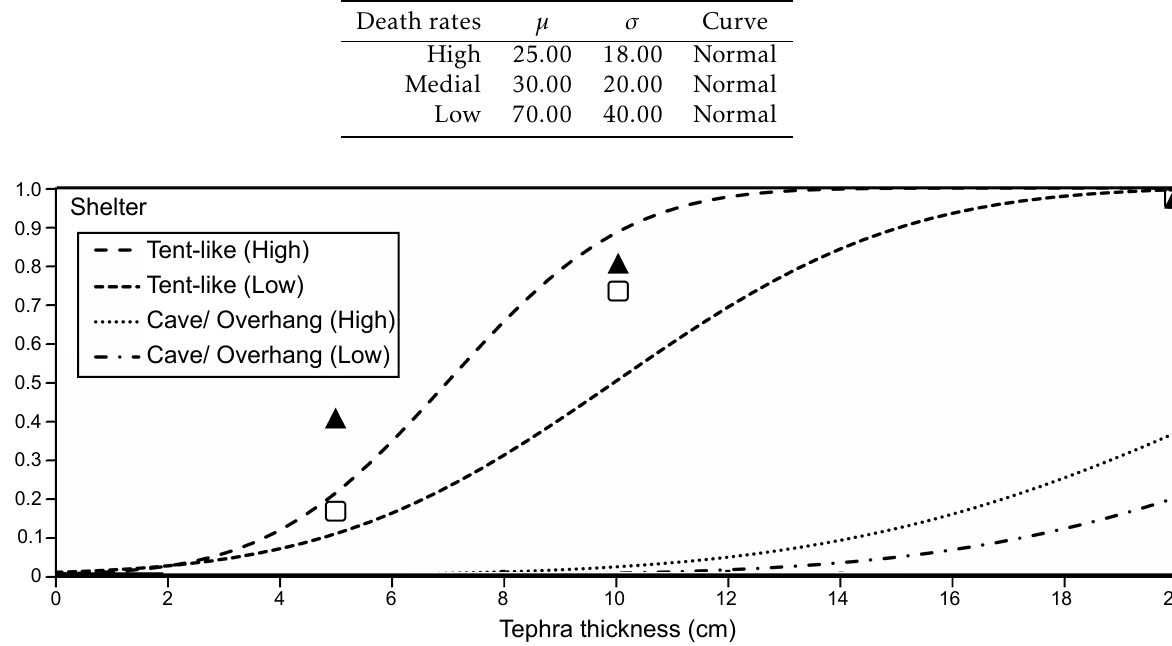
Figure A2: Estimated high and low vulnerability indices for tent-like and cave/overhang shelter types for 0–20 cm of tephra fall from the Laacher See eruption. Boxes = Participant A, Triangles = Participant B estimates of vulnerability for 5, 10, and 18–20 cm of compacted tephra. Table A2 – Fitting parameters for vulnerability curves based on shelter in Figure